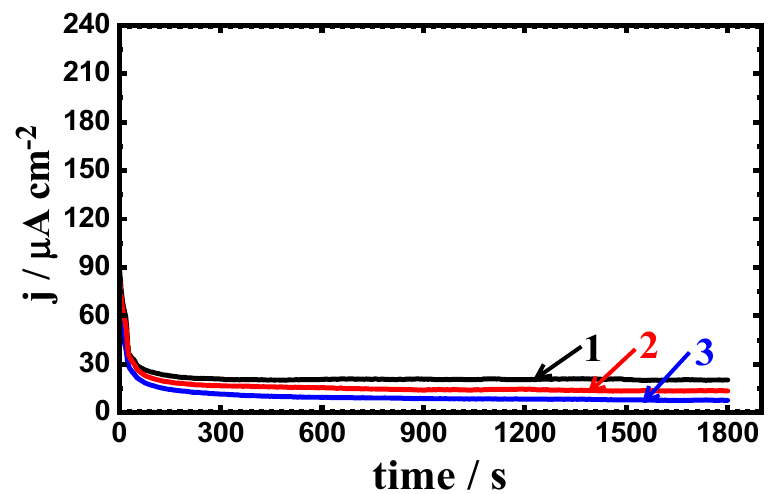
Figure 10. Change of current with time curves for (1) PS, (2) PSC1, and (3) PSC2 at − 700 mV in 4% NaCl solution after 48 h of exposure.